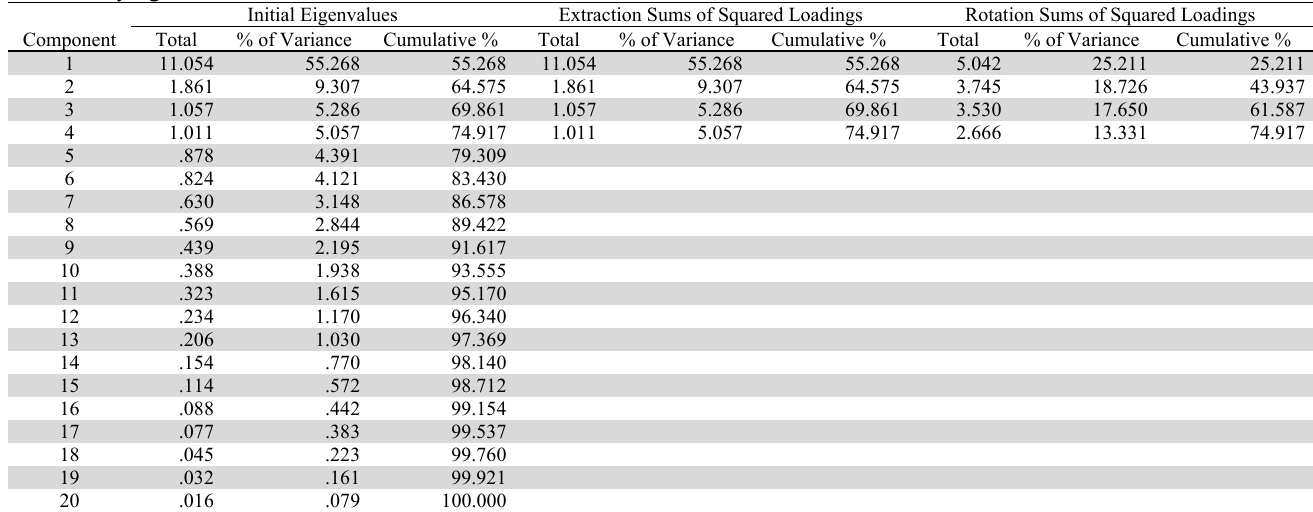
100.000 Extraction Method: Principal Component Analysis.